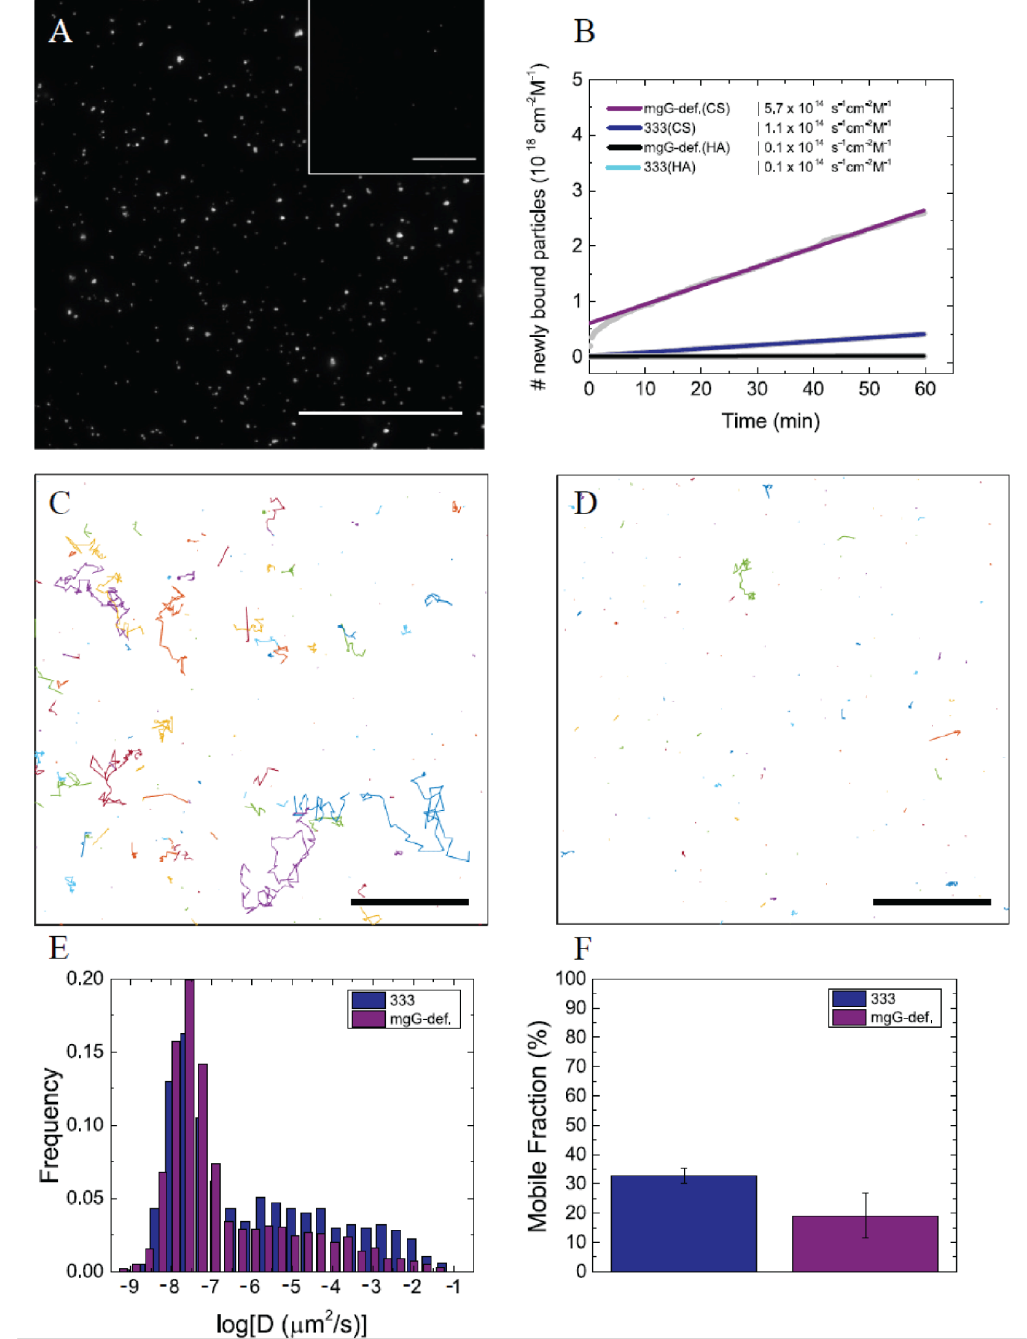
Figure 5. TIRF microscopy to quantify HSV-2 binding and mobility to end-grafted GAG chains. ( A ) TIRF images showing fluorescently labeled HSV-2 strain wt333 particles bound to chondroitin sulfate (CS) and hyaluronan (HA) (inset). Scale bar: 50 µm. ( B ) Cumulative plot of newly bound particles over time, including linear fits, for the wt333 and mgG deficient (mgG-def) mutant virus on CS and HA. The data was normalized to the virus concentration, yielding a slope proportional to the association rate constant (k on ) and allowing for a direct comparison of the association behavior of both viruses. The association curves were corrected to account for the differences in particle concentration of the two virus suspensions. ( C , D ) Mobile trajectories of HSV-2 strain 333 (in C ) and mgG-def (in D ) on CS, determined by SPT analysis of a representative TIRF movie. Scale bars: 20 µm. ( E ) Histograms of diffusion coefficients for HSV-2 333 and mgG-def particles diffusing on CS. ( F ) Mobile fractions of wt333 and mgG-def viral particles diffusing on CS as determined from the histograms of diffusion coefficients.